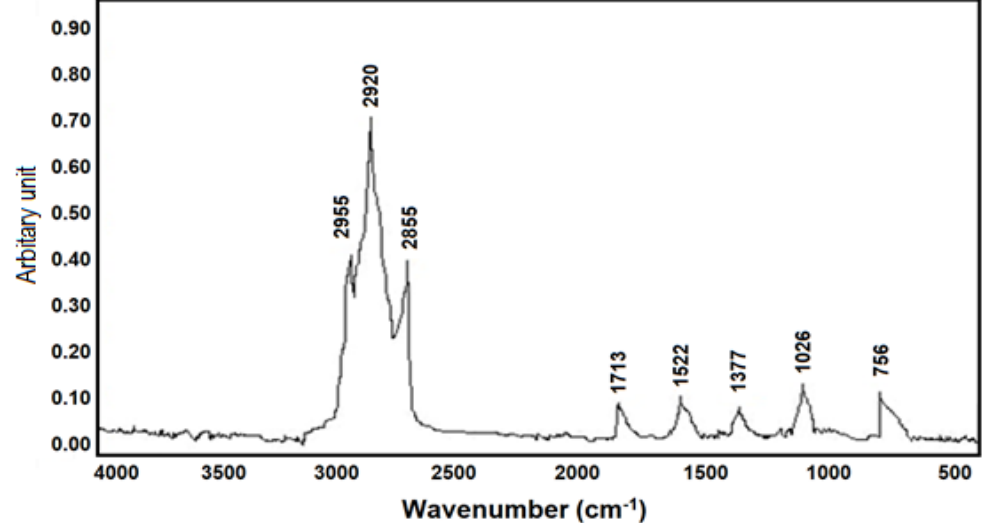
Figure 6. Fourier transform infrared (FTIR) spectra of functional groups identified in SSP.